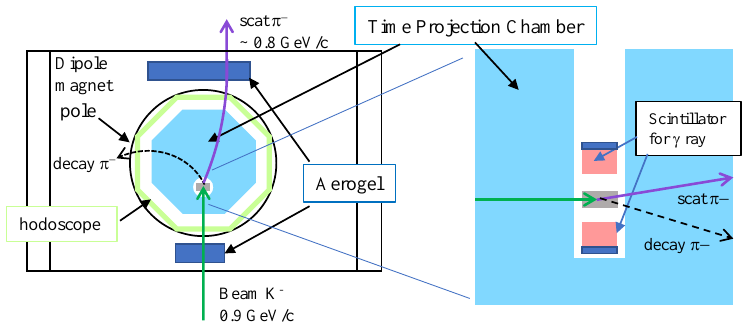
Figure 7. Conseptual design of the hypernuclear (cid:13) -weak coincidence experiment to measure the life- time of the state in which the (cid:13) decay and the weak decay are competing. Dipole magnet and time projection chamber are assumed as the type of J-PARC E42